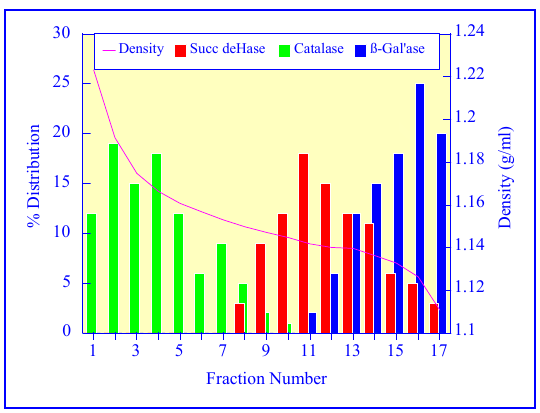
FIGURE 1 . Isolation of peroxisomes in a self-generated gradient of iodixanol: enzyme distribution. Succ deHase = succinate dehydrogenase, ß-Gal’ase = ß-galactosidase.